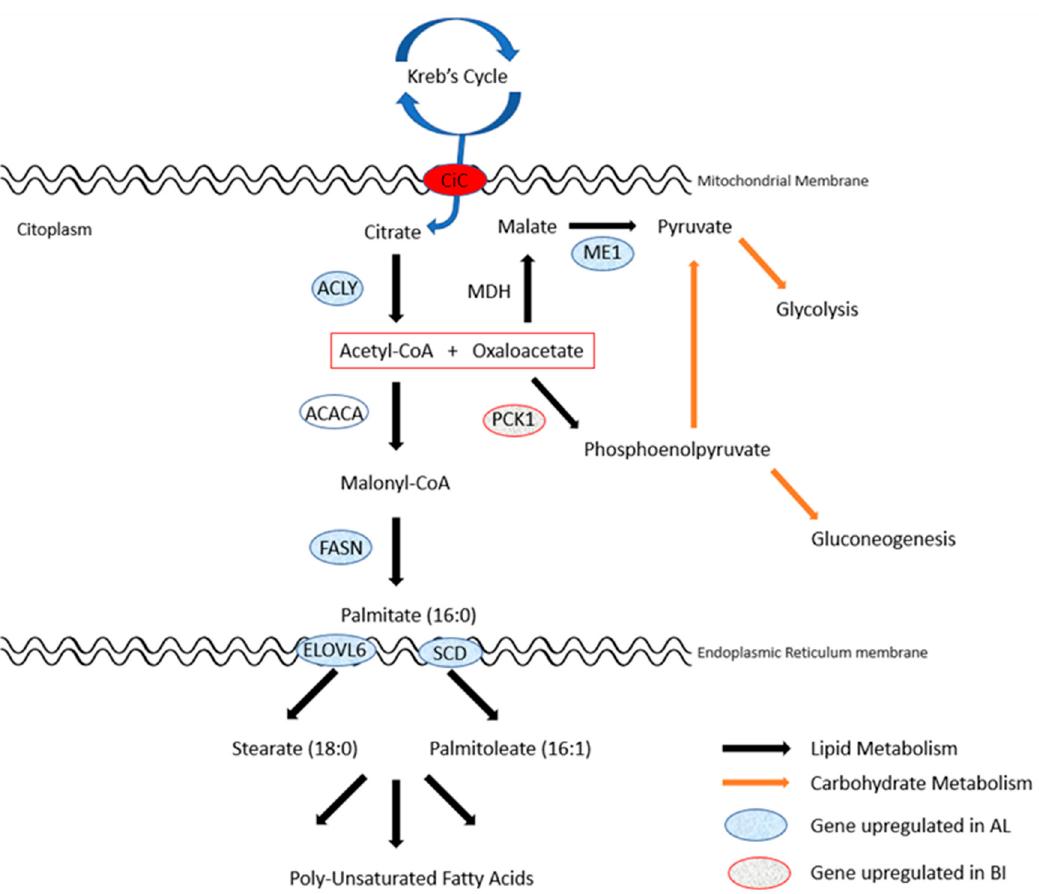
Figure 1. Linking lipid biosynthesis with carbohydrate metabolism: direction of upregulated genes in the Portuguese local pig breeds.